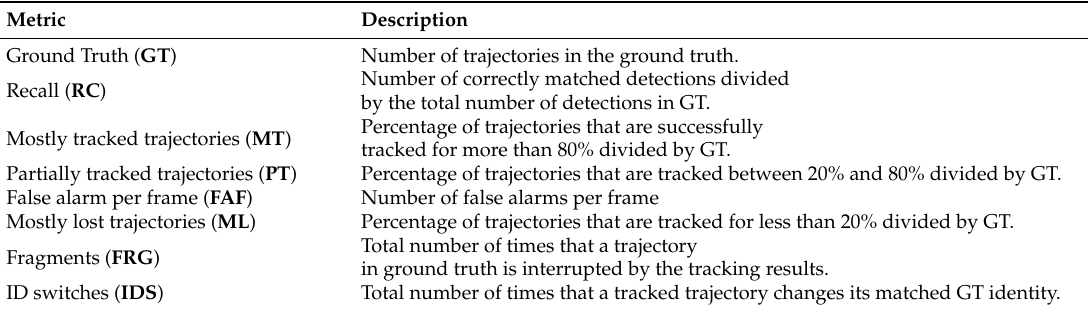
Table 2. Evaluation